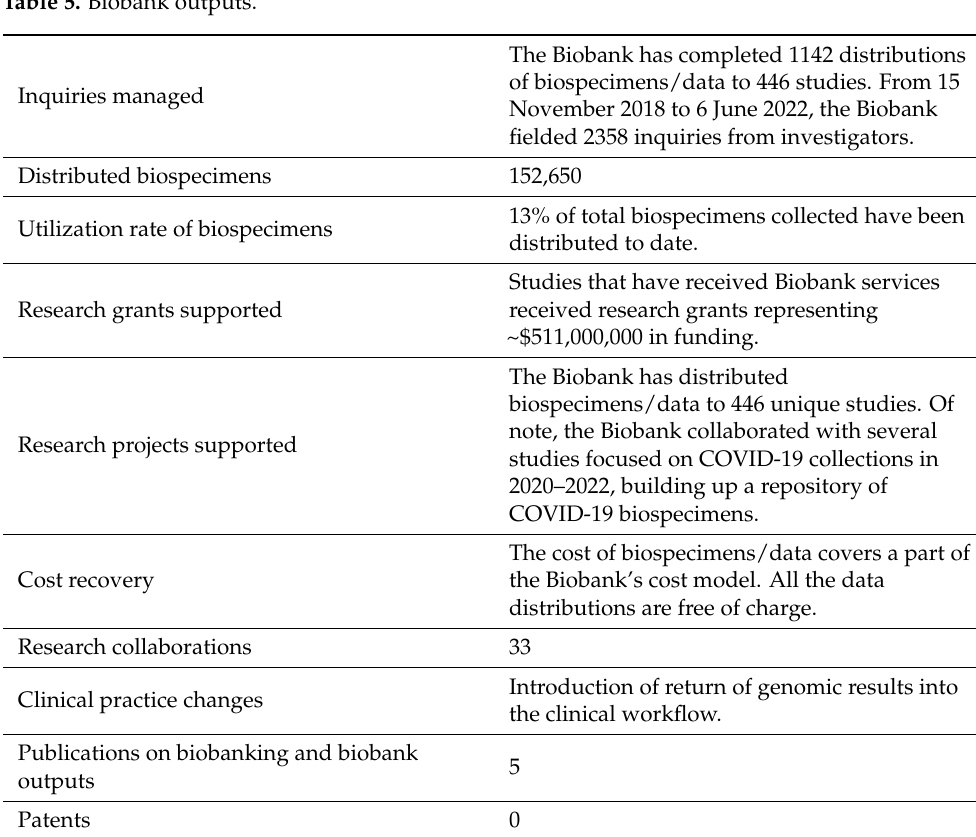
Table 5. Biobank